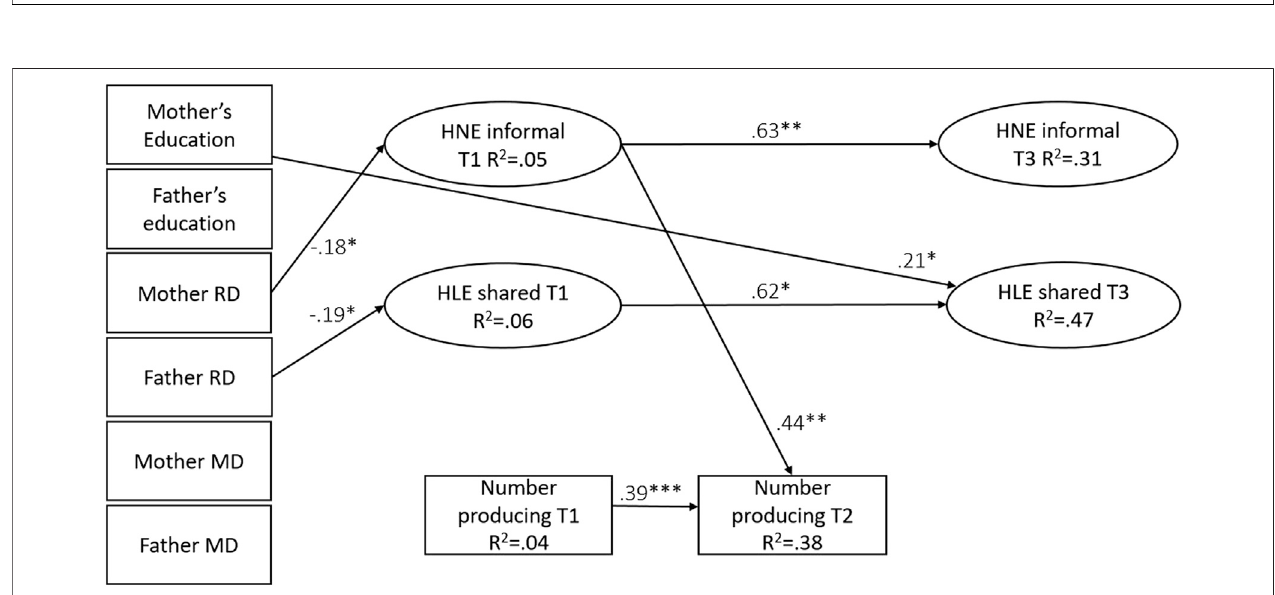
FIGURE5| Themodelfornumber productionwithsigni fi cantstandardizedestimates. Note: Inadditiontotheregression pathsdepicted,therewasonesigni fi cant residual correlation: between HNE and HLE at T1 (stand. estimate (cid:1) 0.41***).